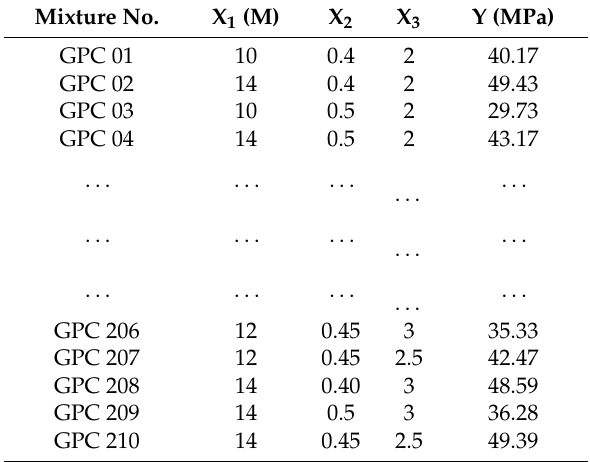
Table 4. Mix proportions and compressive strength results of GPC using steel slag